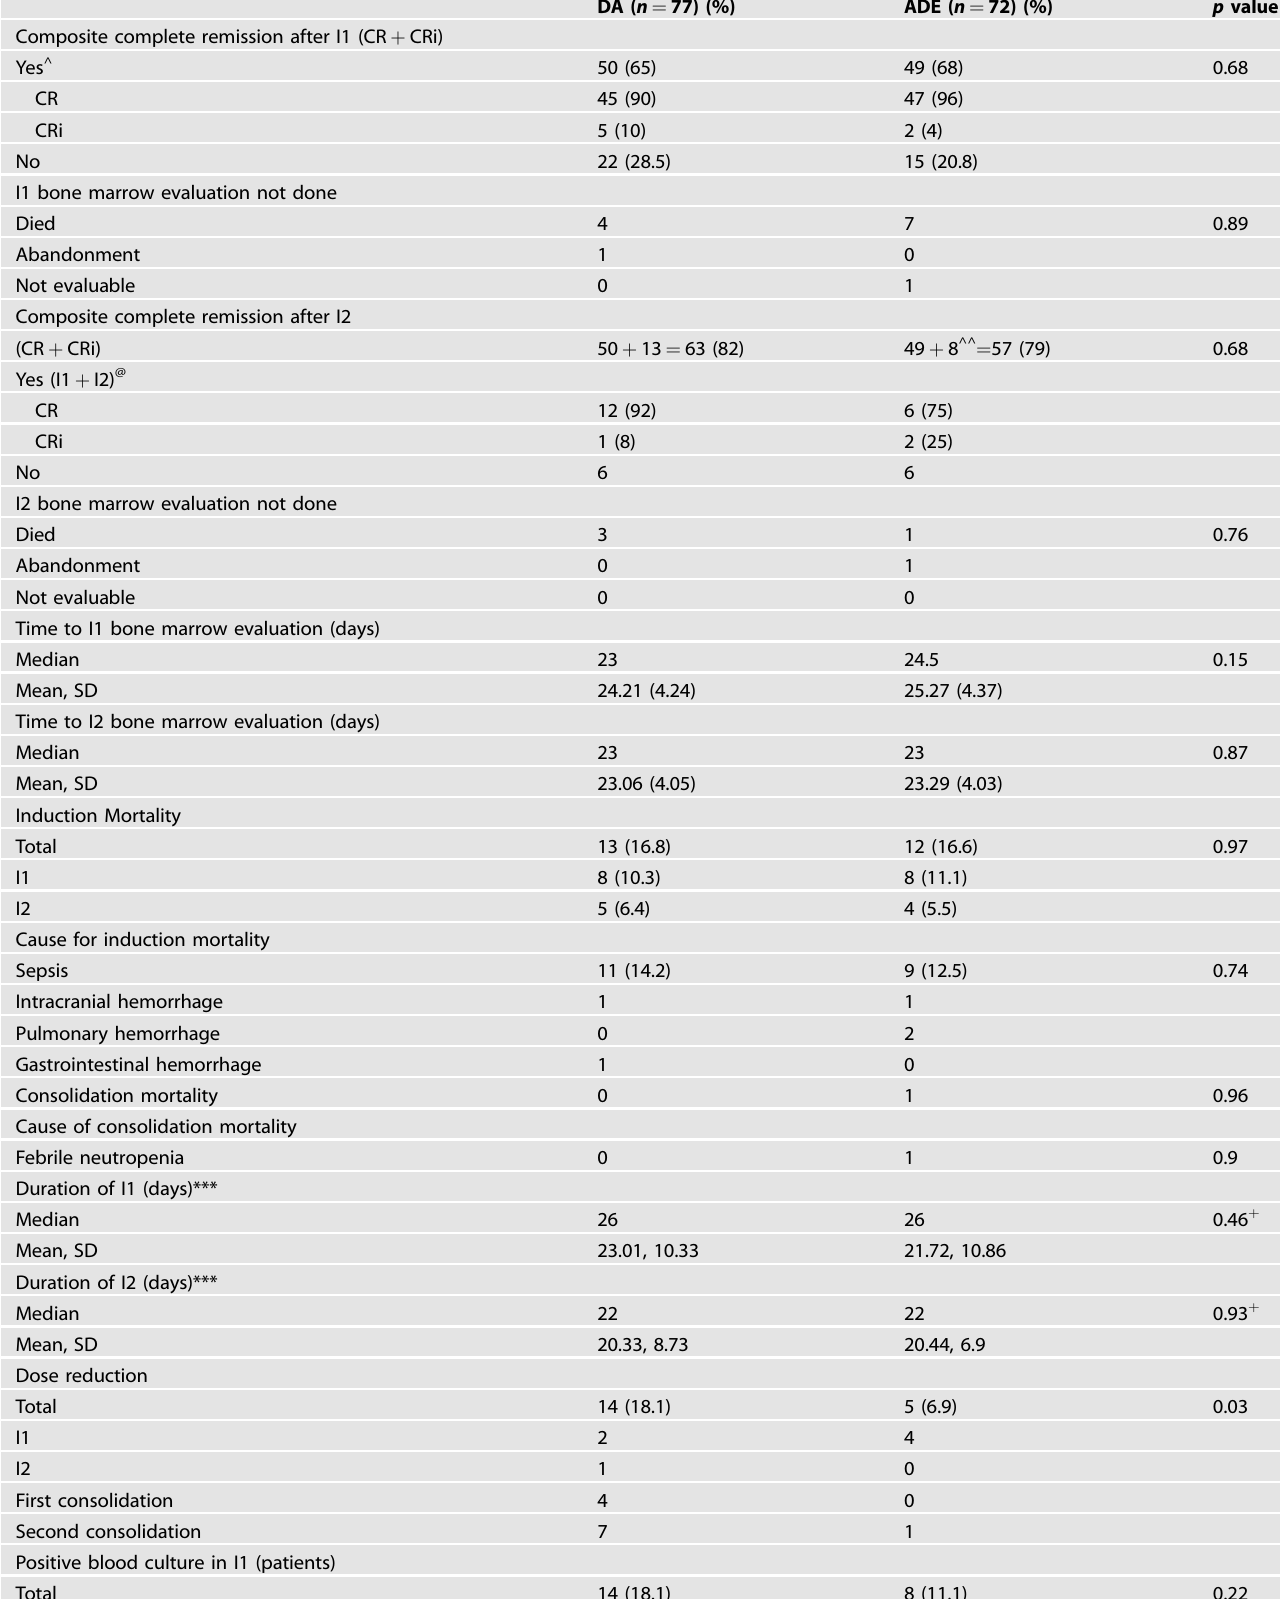
Table 3. Comparison of outcomes between the DA and ADE